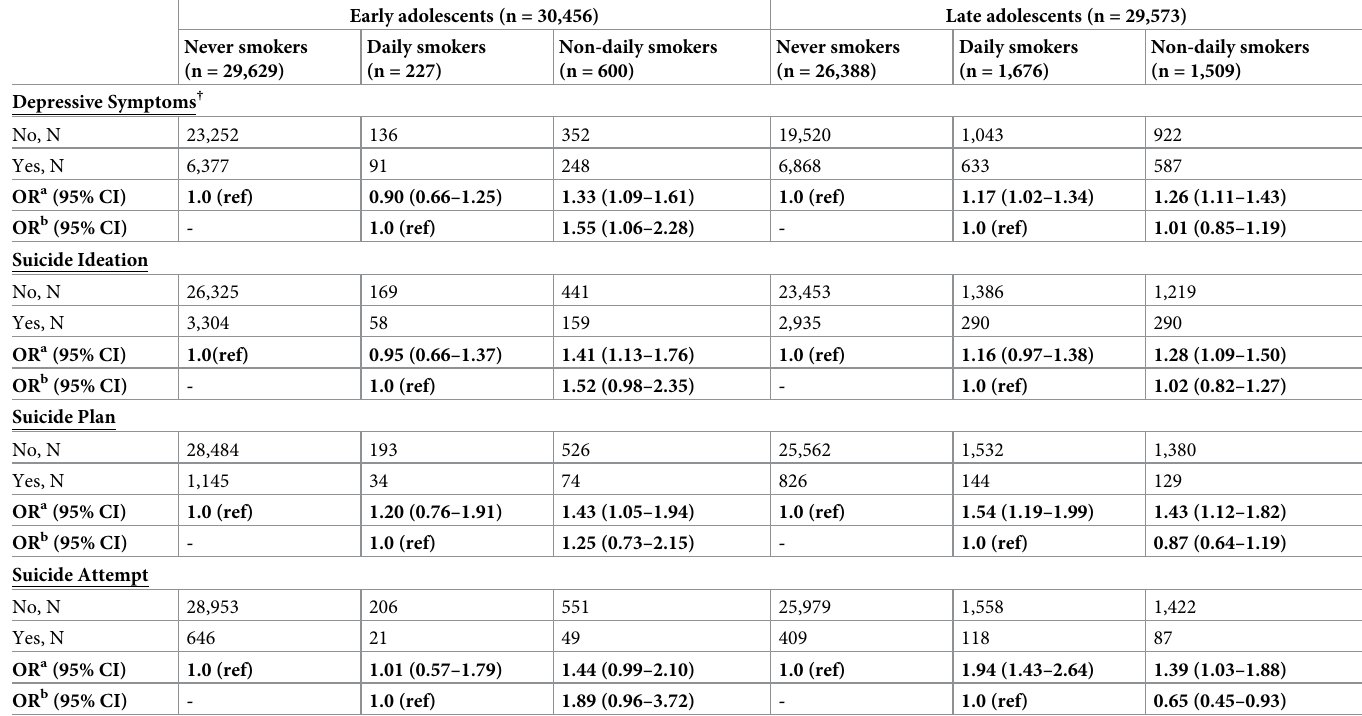
Table 4. Association of depressive symptoms and suicidal behaviours with smoking patterns (KYRBS, 2016, Korean adolescents aged 12–18